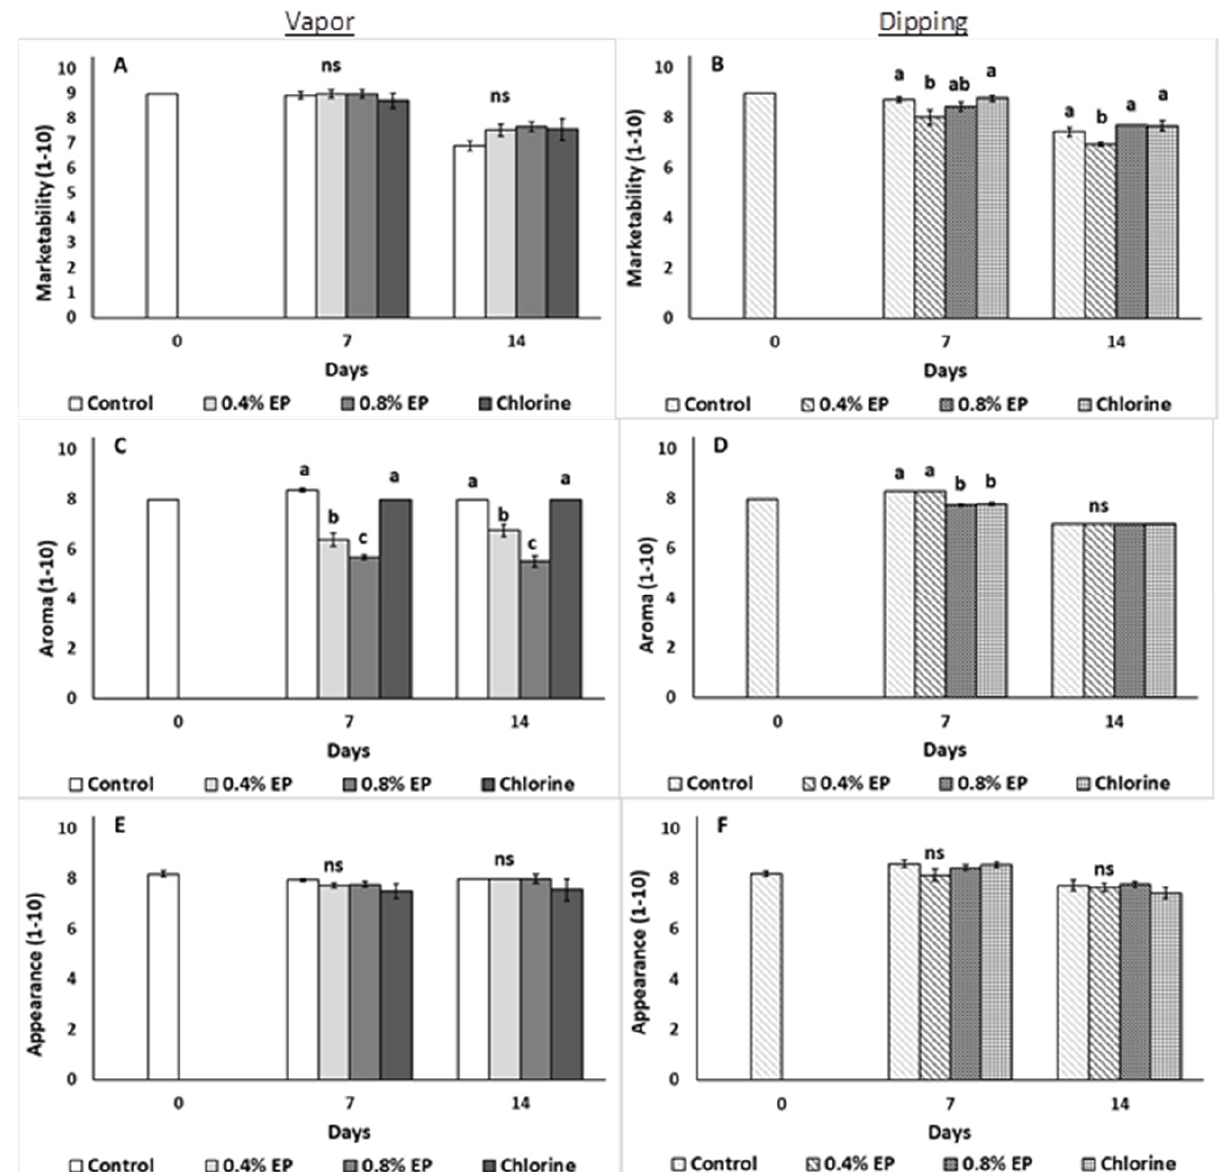
Figure 4. Effects of vapor ( A , C , E ) or dipping ( B , D , F ) application with eco-product (EP) at different concentration (0–0.4% and 0.8%), chlorine (0.02%) or control (application with water) on marketa- bility (scale 1–10), aroma (scale 1–10) and appearance (scale 1–10) of cucumber fruits stored at 11 °C and RH ~90% up to 14 days. Means ± SE followed by different Latin letters are significantly different according to Duncan’s MRT ( p = 0.05). ns: not significant.